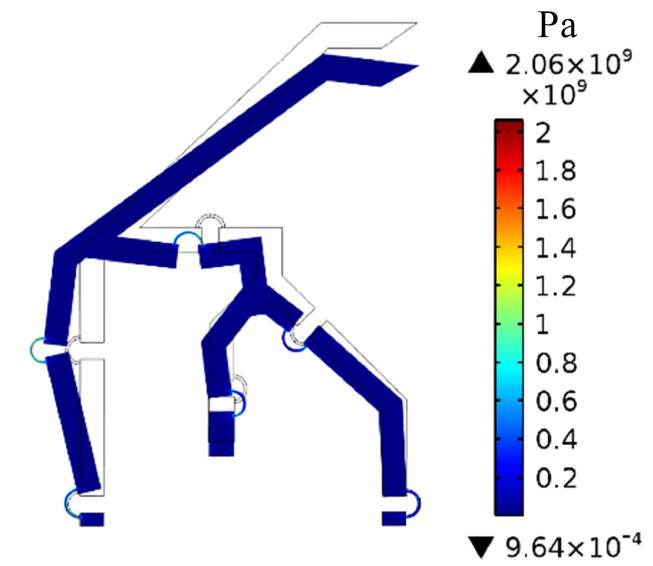
Figure 18. Distribution of the von Mises stress on the proposed compliant mechanism for the maximum input force ( F m = 5.4 mN).